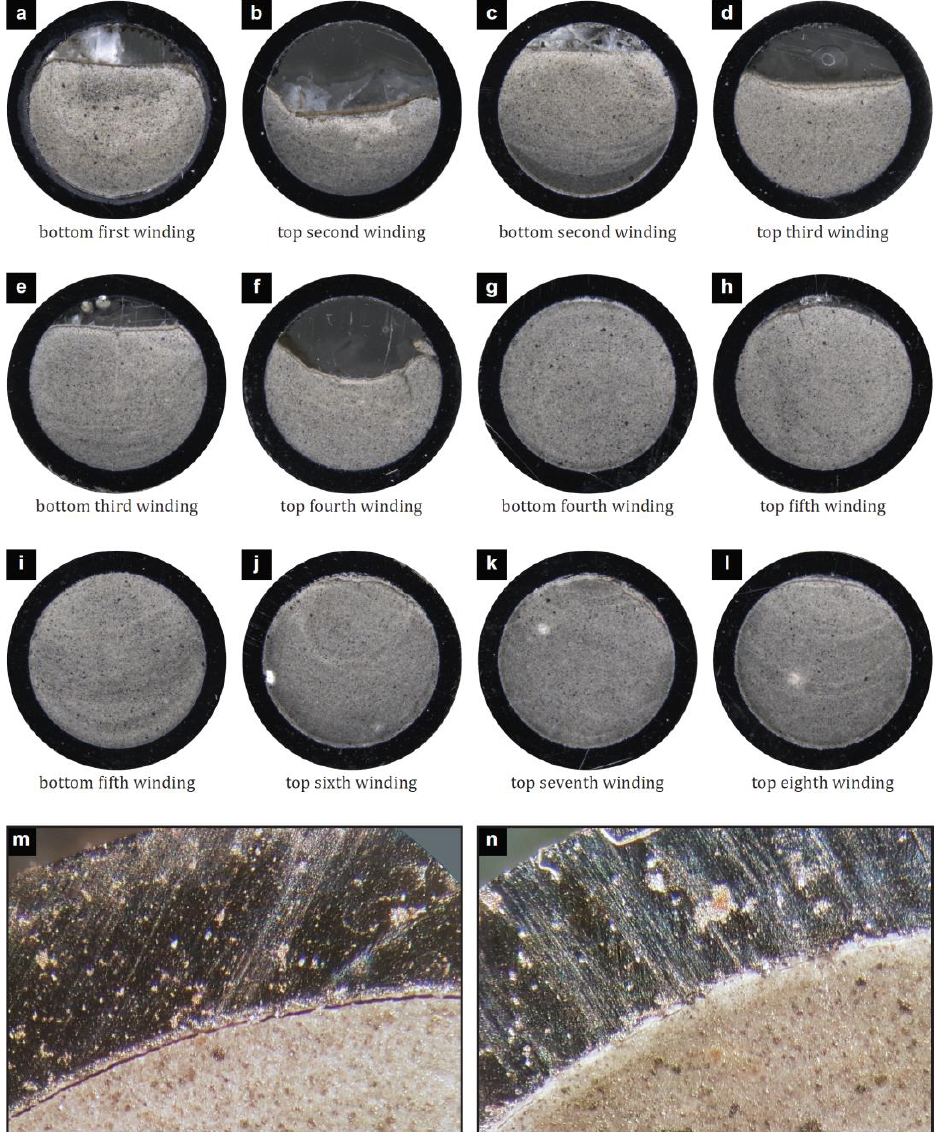
Figure 6. Photographs of cross-sections made through sample SIL-1 after completing the reactive flow-through experiment. Panels ( a – l ) show cross-sections obtained at progressively greater distances from the fluid inlet — the location of the origin, with respect to the coil windings. is indicated (see also Figure 1a); ( m ) example of an open micro-annulus, visible as a black line along the circumference of the cement; ( n ) example of a clogged up micro-annulus, visible as a white band along the circumference of the cement. Wall thickness of the steel tube = 1 mm, for scale.